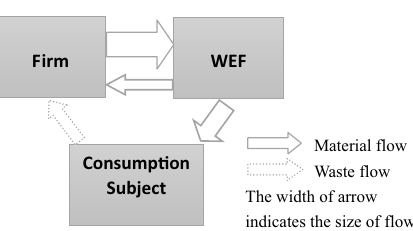
Figure 1. Sub-types